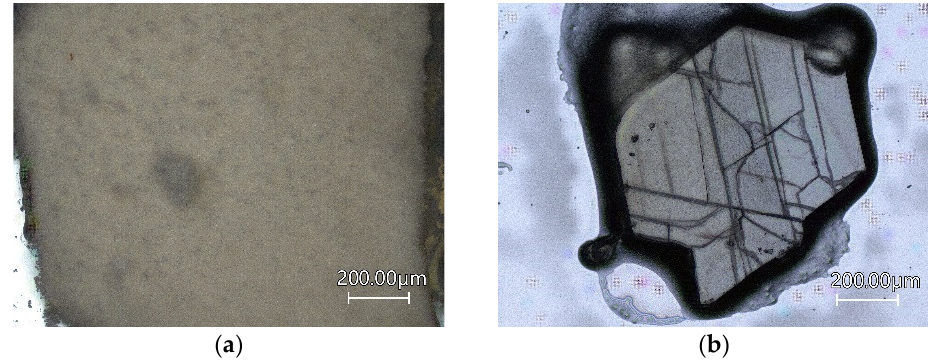
Figure 10. The light microscope images of samples of [Nd( L3 ) 2 (NO 3 ) 3 ] (5): ( a ) amorphous bulk material; ( b ) crystalline sample.